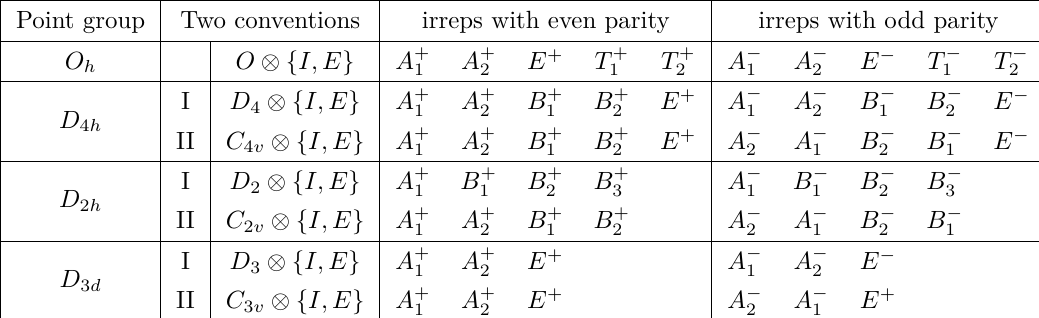
Table 2 . Irreps of the relevant point groups using the two conventions as discussed in the text and their corresponding relations. The convention I is adopted in refs. [4, 37] and in this paper. The convention II is employed in refs. [6,